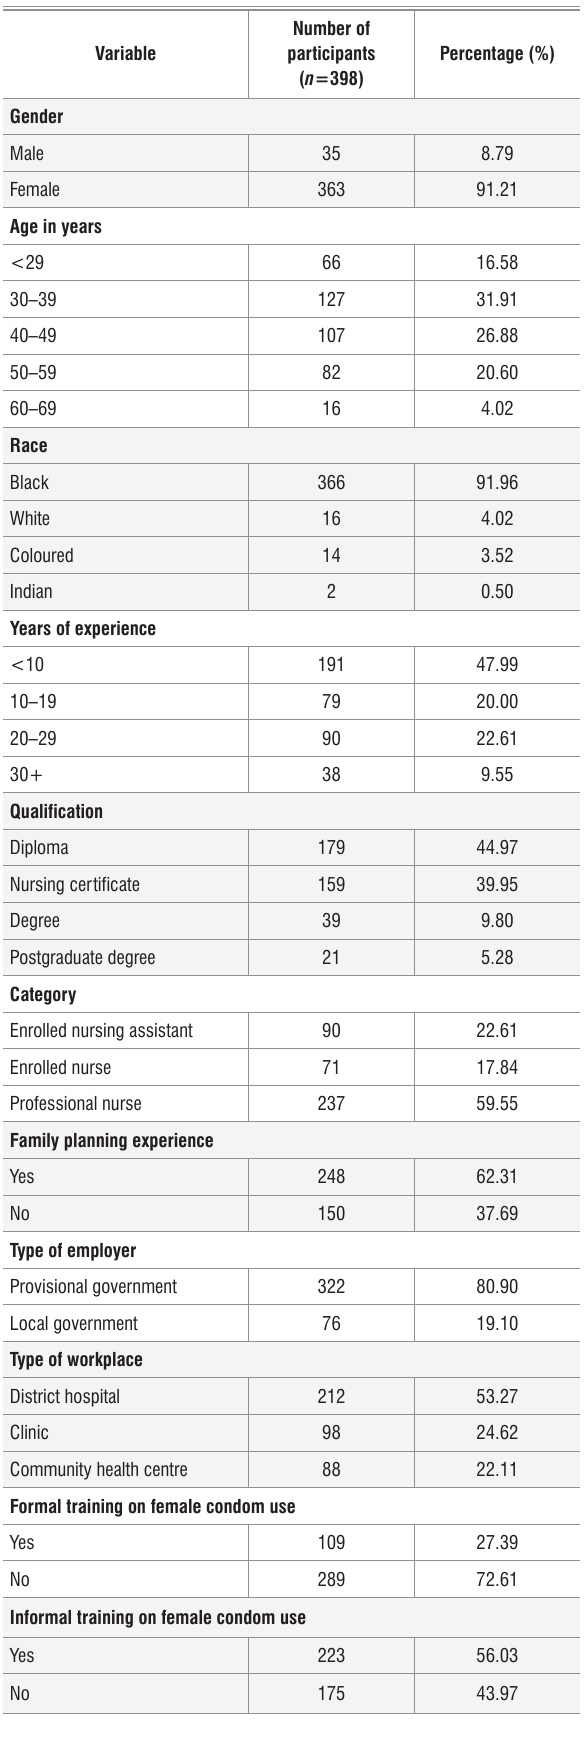
Characteristics of the participants who completed the